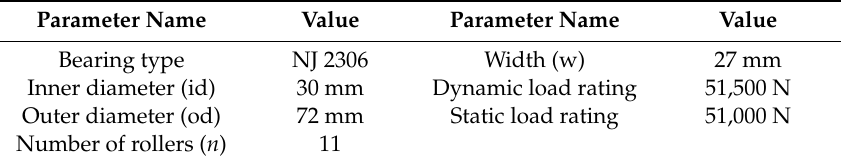
Figure 12. Korea Aerospace University (KAU) bearing test rig. Table 1. Bearing dimensions.